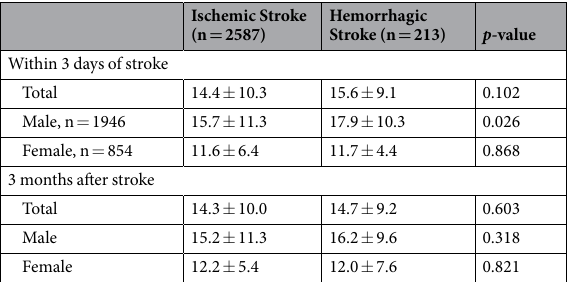
Table 2. Changes in tHcy levels within three months of an acute stroke, by stroke subtype and